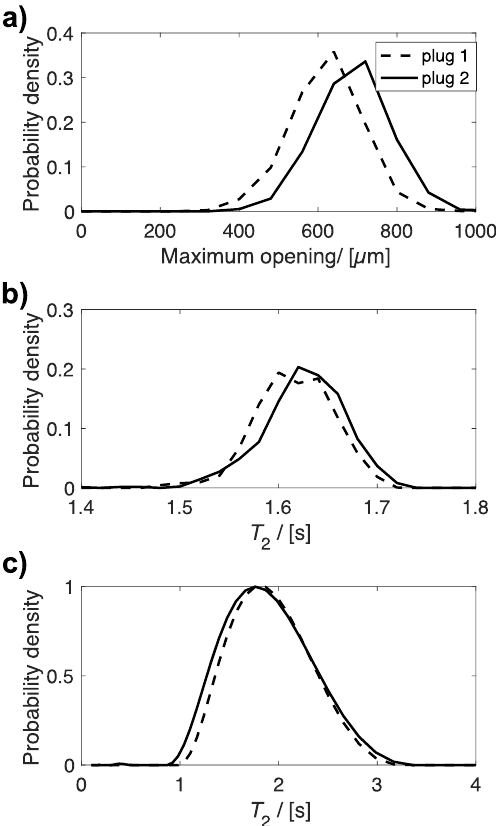
Figure 6. Plots of the distribution of ( a ) maximum opening, ( b ) T 2 relaxation time, determined from MR T 2 maps, and ( c ) bulk T 2 relaxation times for two different uncompressed plugs.